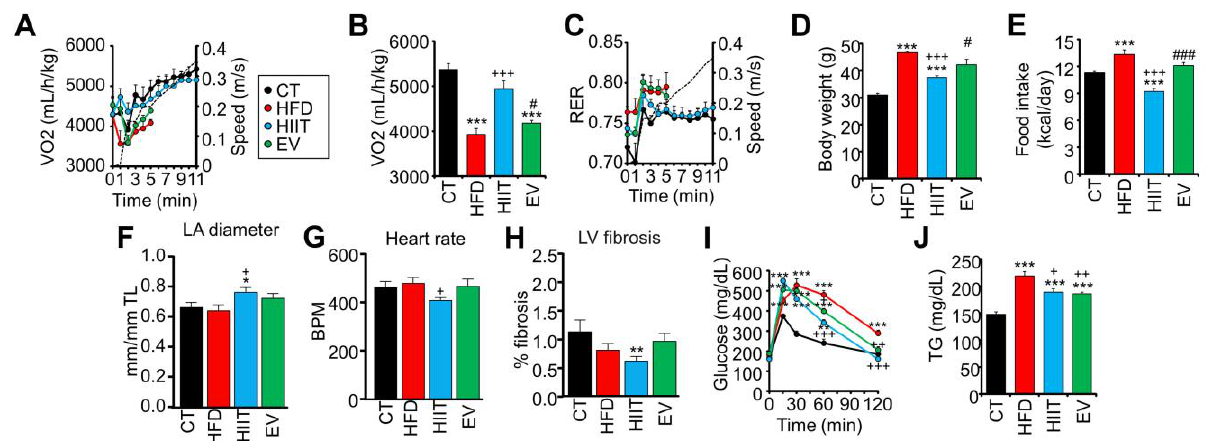
Figure 2. HIIT and EV-miRNAs improve the metabolic profile of HFD mice, but only HIIT enhances CRF and promotes cardiac remodeling: ( A – C ) Obese mice trained by HIIT showed increases in their time spent running ( A ), maximal VO 2 ( B ), and metabolic flexibility ( C ) during a capacity test on a treadmill. Treatment with EV-miRNAs did not affect these parameters. ( D , E ) HIIT, but not EV treatment, significantly decreased the body weight of obese mice ( D ), associated with lower food intake ( E ). ( F – H ) Trained mice developed significant sinus bradycardia ( F ), left atrial dilation ( G ), and showed decreased myocardial fibrosis in the left ventricle ( H ). ( I , J ) Both HIIT and EV improved glucose tolerance ( I ) and decreased plasma triglyceride levels ( J ). n = 6/group ( A – J ); * p < 0.05, ** p < 0.01, *** p < 0.005 with respect to the CT group; + p < 0.05, ++ p < 0.01, +++ p < 0.005 with respect to the HFD group; # p < 0.05, ### p < 0.005 between the HIIT and EV